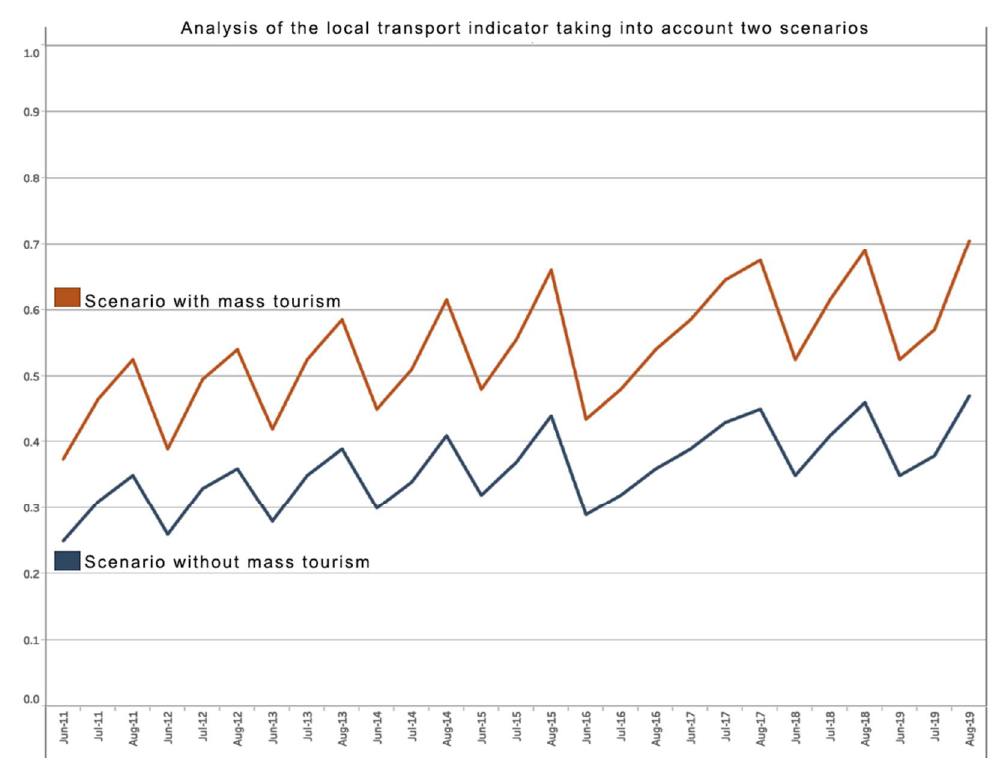
Figure 5. Local transport activity in the two scenarios.